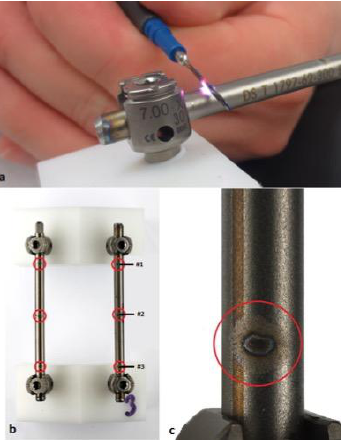
Figure 1. Electrocautery application. ( a ) Electric light arc, ( b ) sites, and ( c ) magnified view of the surface impact post electrocautery application. The first site was approximately 5 mm from the cephalic pedicle screw (#1). (#2 was at the center and #3 was analogous to #1 on the other side).